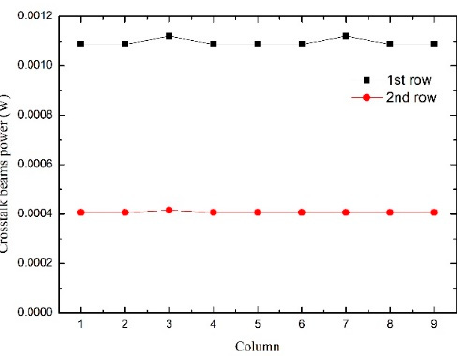
Figure 10. Diagram with crosstalk power values of the two rows. (Y axis, δ = − 2°, θ = − 0.5°). Similarly, through simulation and calculation, the crosstalk power under “Y axis, δ = − 2°, θ = 0°” and “Y axis, δ = − 2°, θ = 0.5°” can be given, as shown in Figure 11.